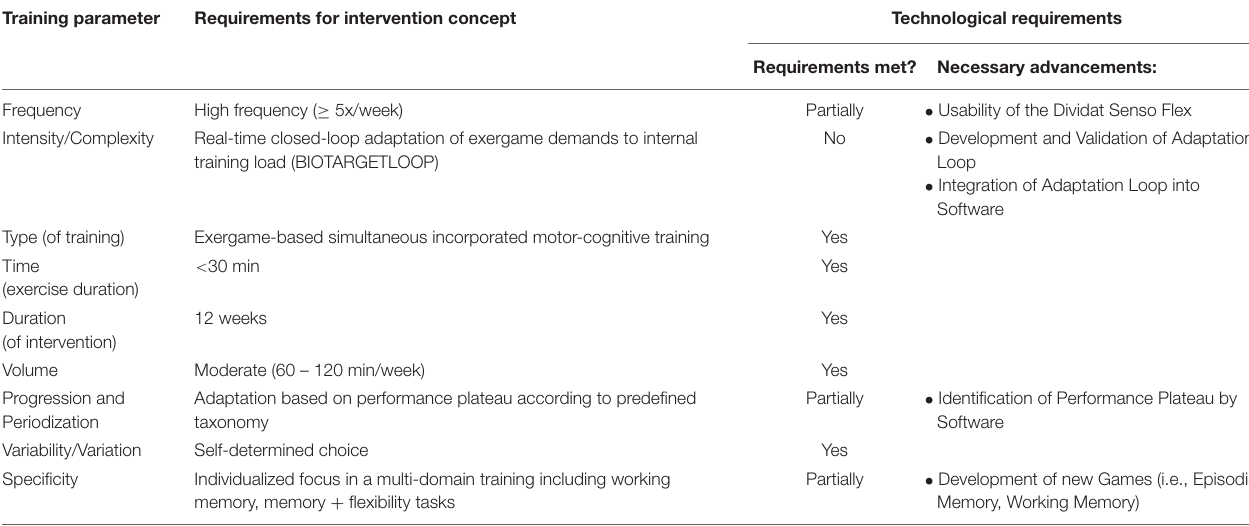
TABLE 3 | Hardware and software requirements of the Dividat Senso for